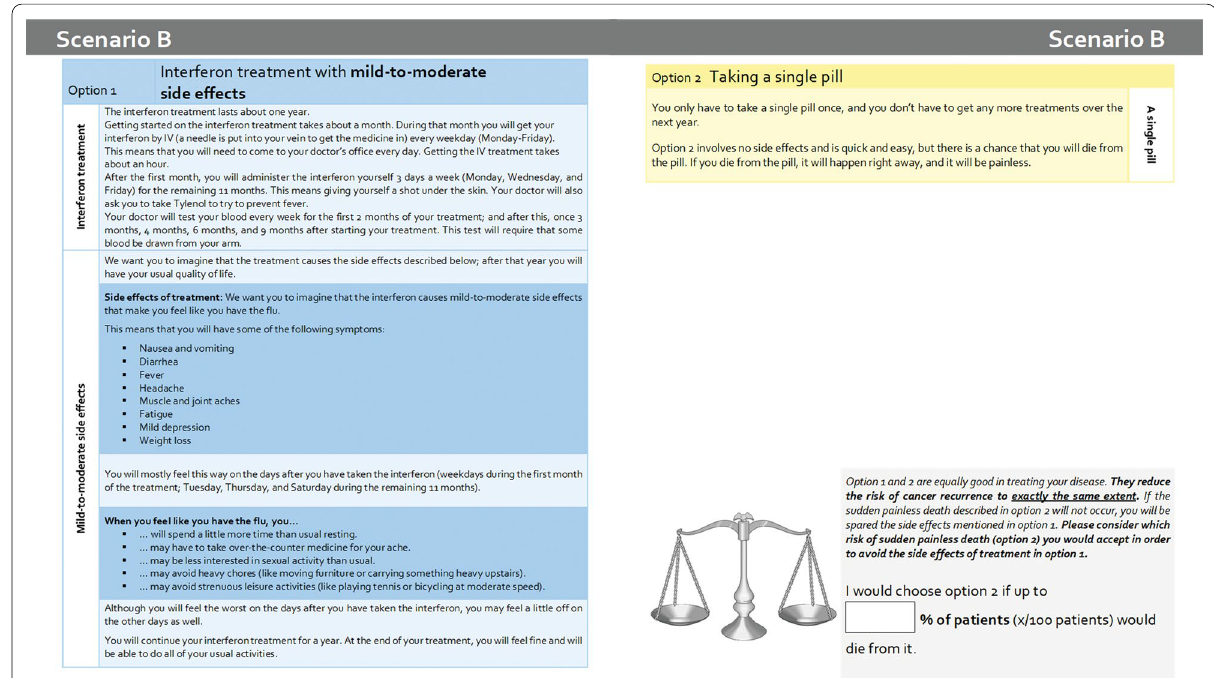
Fig. 1 Example scenario with single-item standard gamble question (own translation from German original